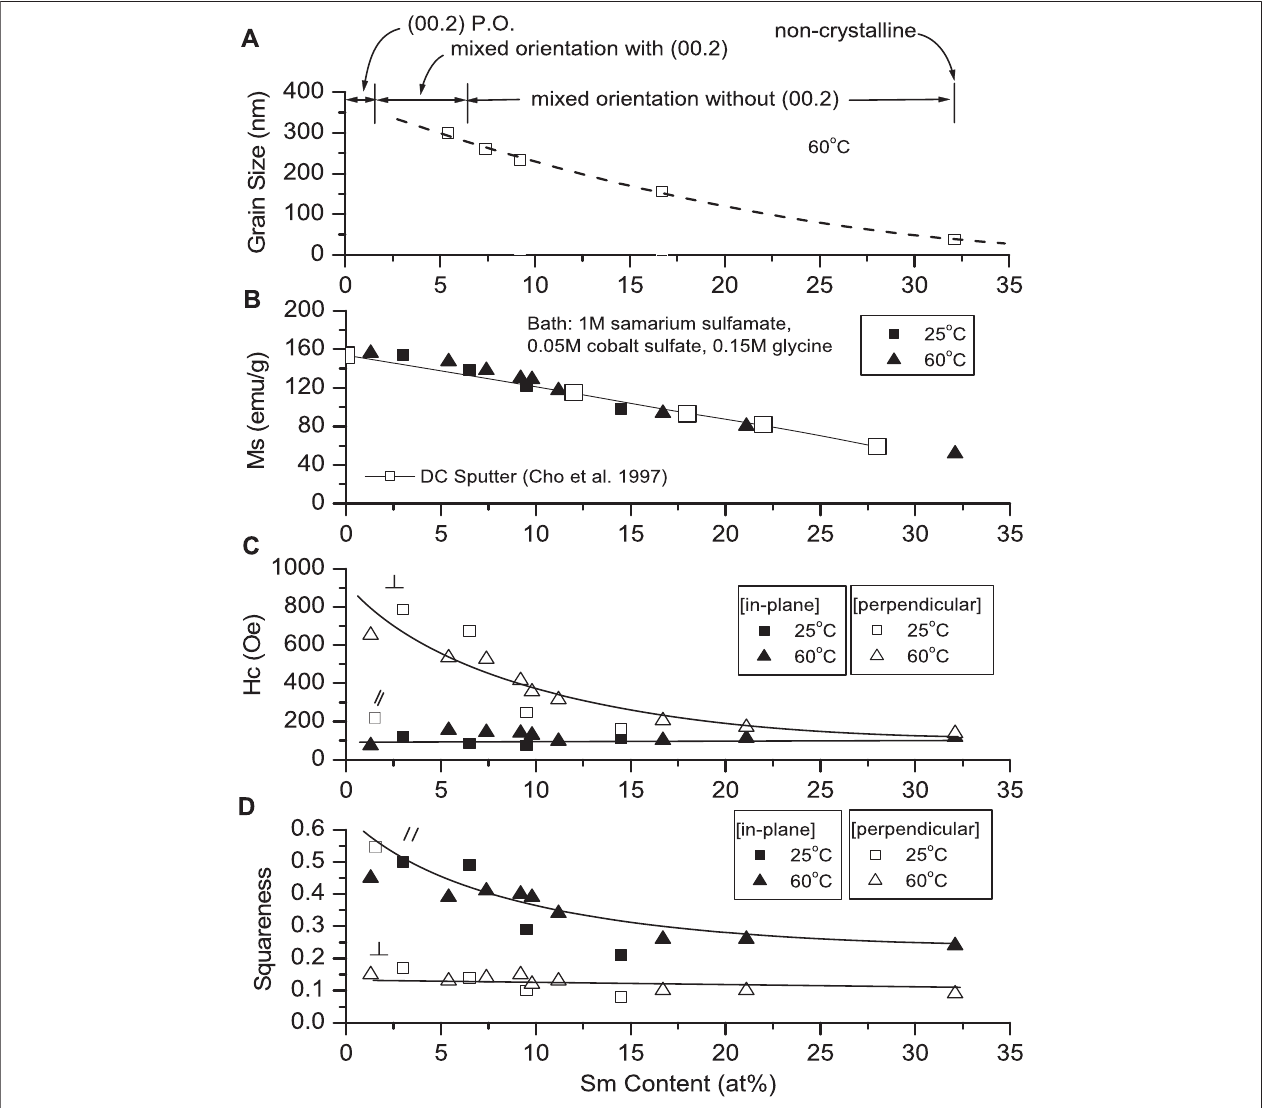
FIGURE 6 | Effect of Sm deposit content and temperature on grain size and magnetic properties.